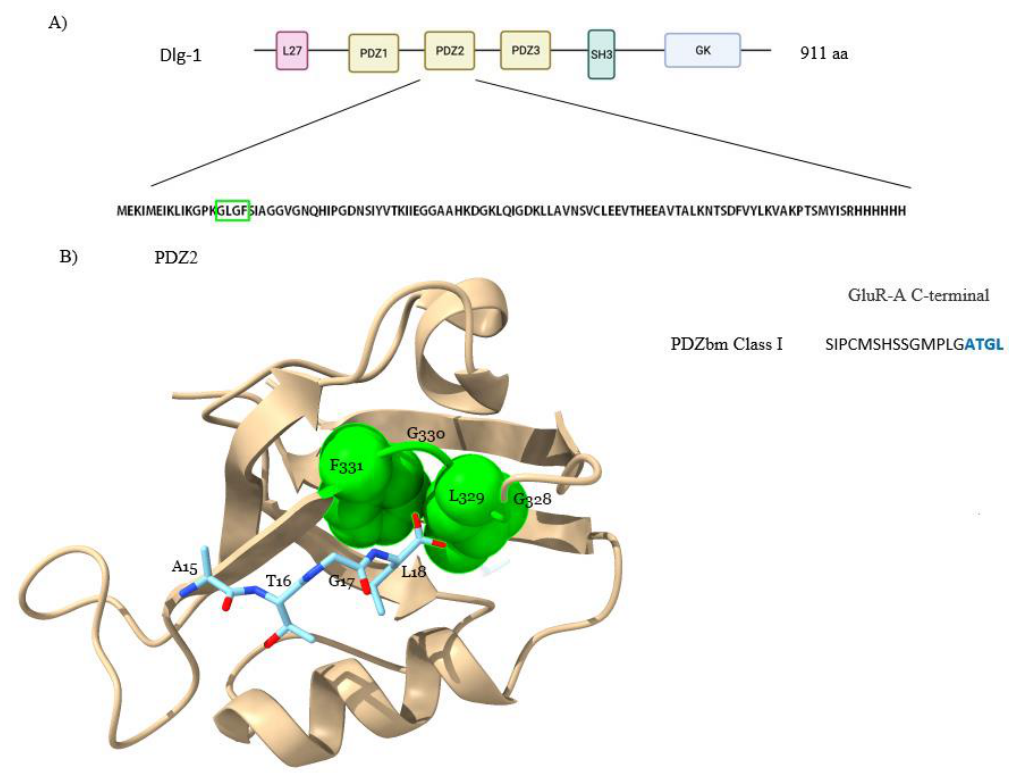
Figure 1. Structure of the second PDZ Domain of Dlg1 in complex with the GluR-A C-terminal PDZbm (PDB ID: 2GLG) . ( A ) Schematic representation of Dlg1 showing its three PDZ domains and the primary sequence of the PDZ2 domain; GLGF sequence is marked in a green box. ( B ) Three-dimensional structure of PDZ2 domain of Dlg1 (golden) in complex with the class I PDZbm of the subunit GluR-A (blue) of glutamate receptors [11]. The conserved GLGF sequence in the PDZ domain is shown in green. The C-terminal sequence of GluR-A including the PDZbm is shown (right). Figure is drawn with ChimeraX 1.2.5. (University of California at San Francisco, San Francisco, CA,